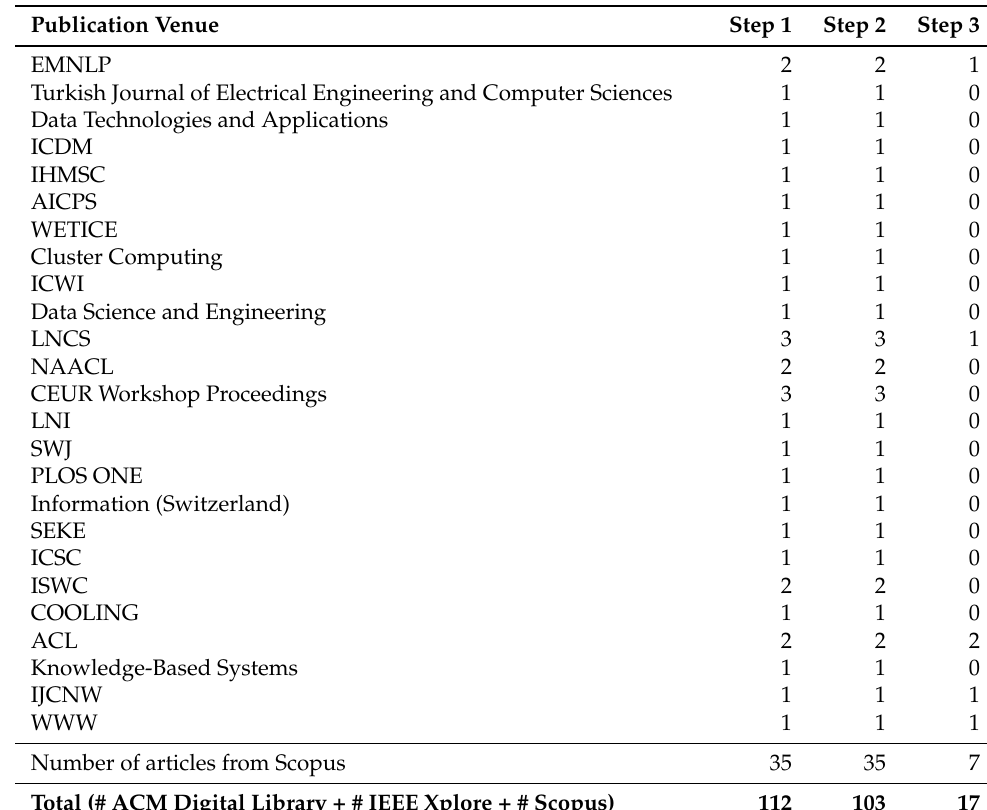
Table A4. The number of articles collected from